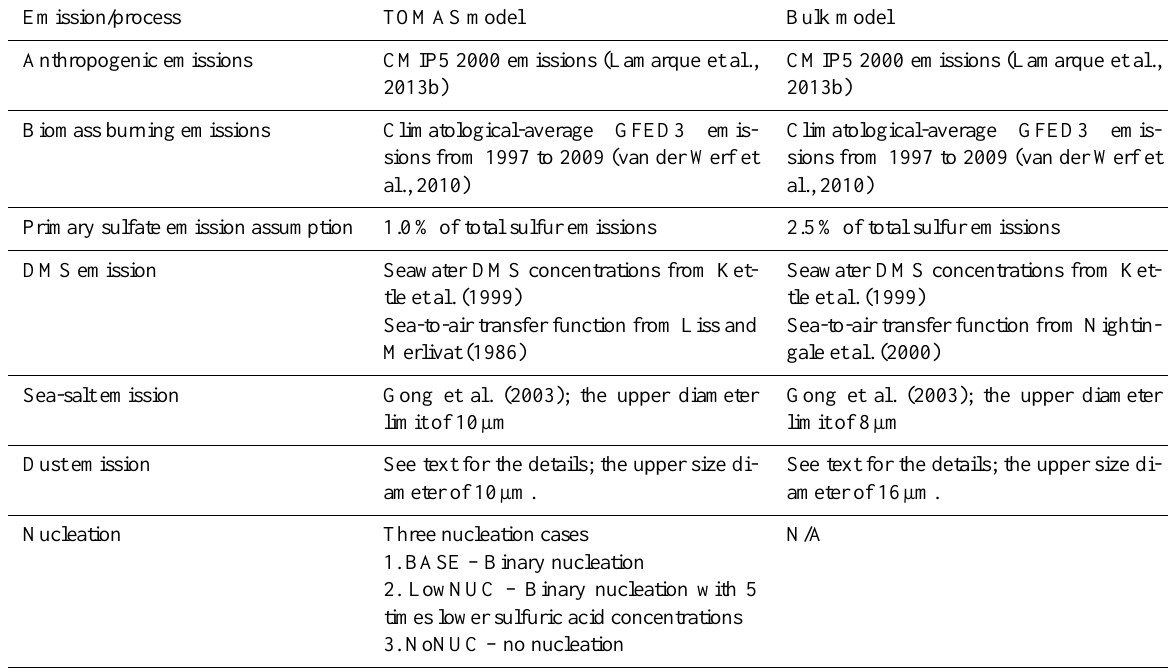
Table 1. Aerosol and precursor gas emissions used in ModelE2-TOMAS and ModelE2-OMA and the nucleation scheme used in the ModelE2-TOMAS